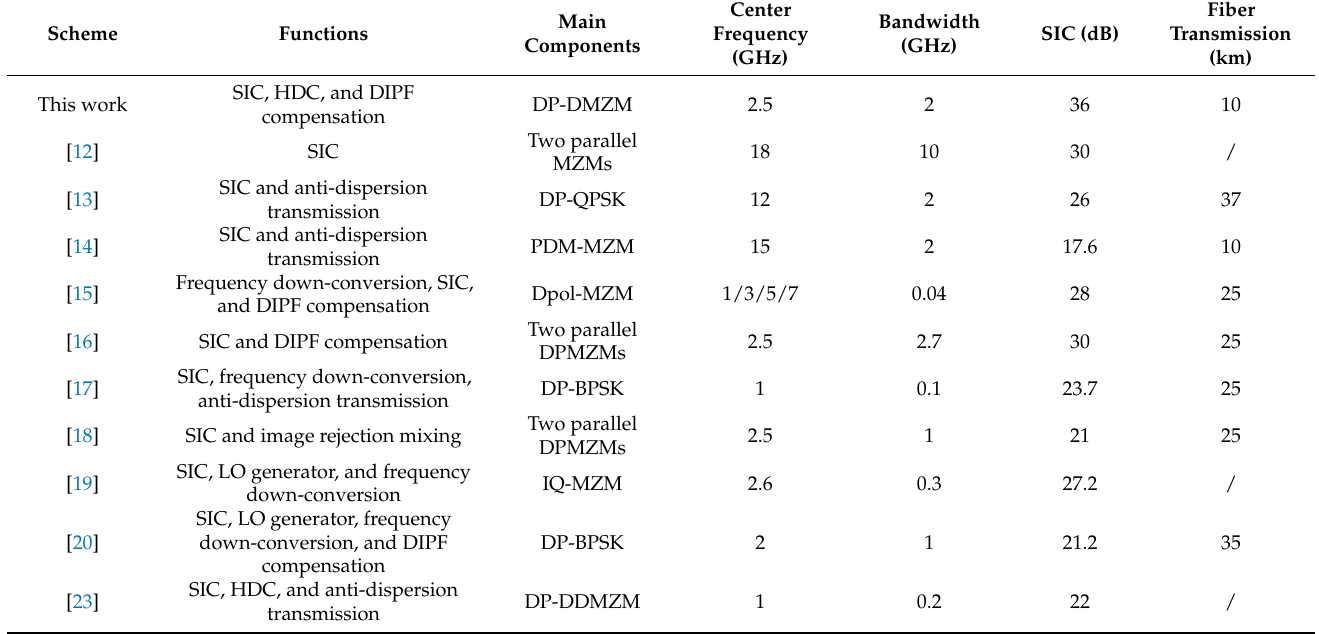
Table 1. Comparison of various